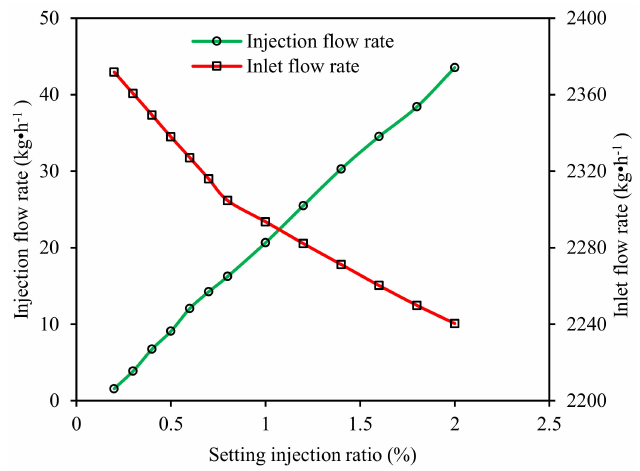
Figure 5. Influence of setting injection rate on Q il and Q ij .